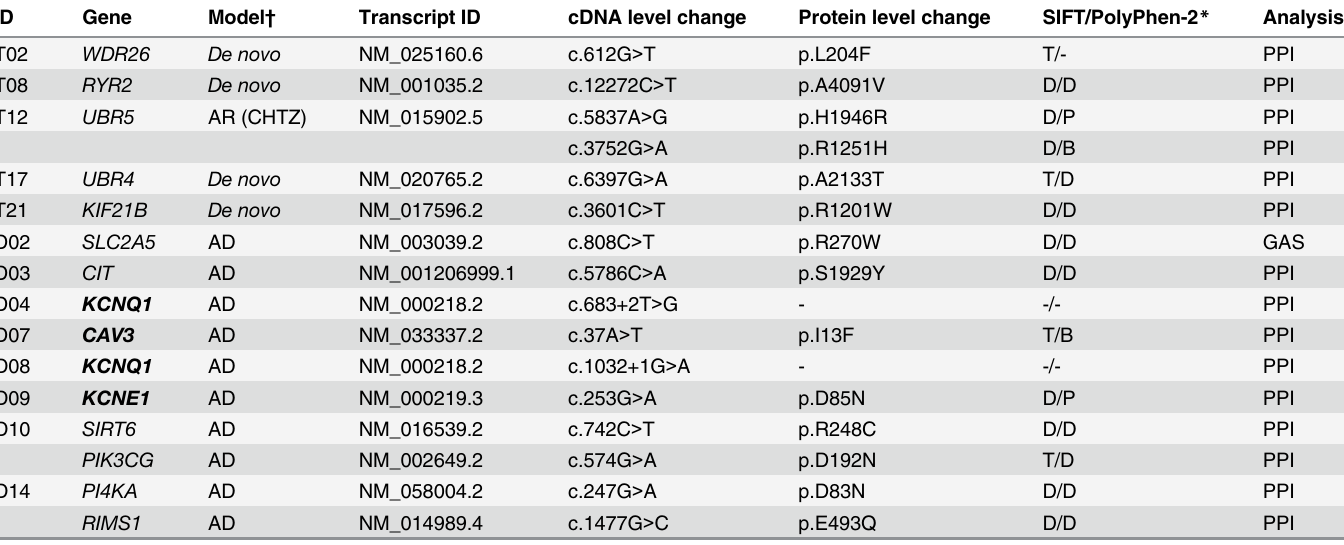
Table 3. Potential pathogenic mutations detected in PPI analysis and Gene based Association Study (GAS) using independent